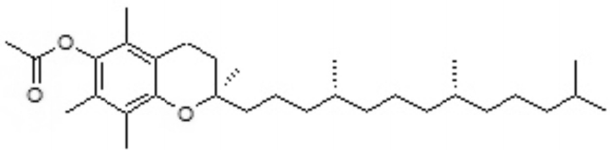
FIGURE 1 – Chemical structure of tocopheryl acetate.